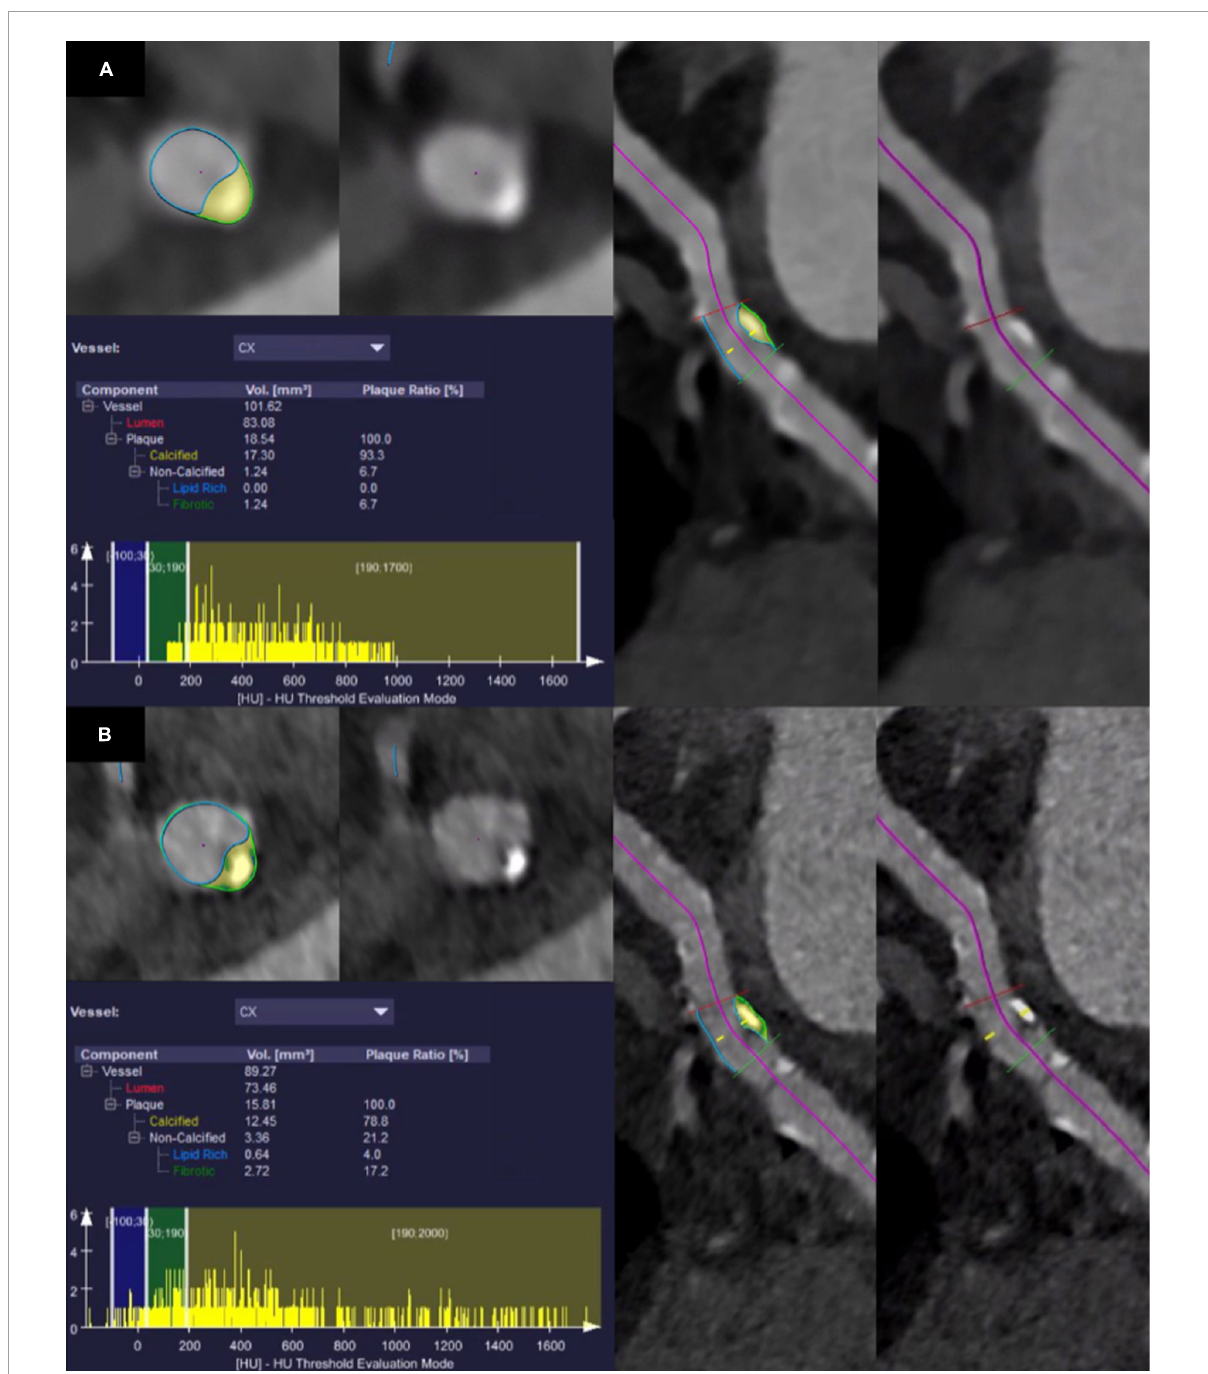
FIGURE1 Segmentation and quantitative results of plaque characteristics in the circumflex artery of a 75-year-old male patient who underwent coronary CT angiography with photon-counting detector CT. Note the shift of CT values in the histogram towards lower values using ultra-high-resolution reconstructions with a slice thickness of 0.2 mm and the Bv64 kernel (B) compared with reconstructions with a slice thickness of 0.6 mm and the Bv40 kernel (A) .